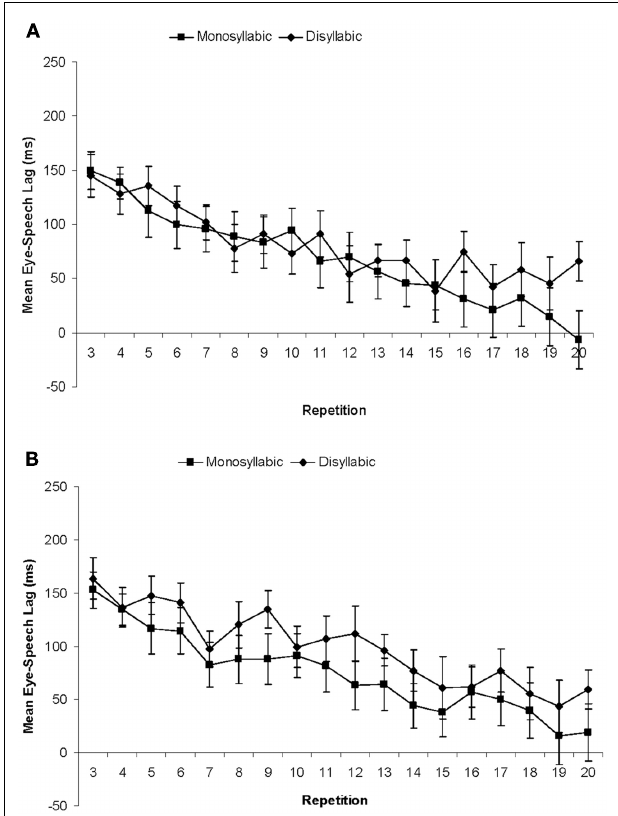
FIGURE 9 | Results of Experiment 2. Mean lags (ms) for monosyllabic and disyllabic items on repetitions 3 through 20 in the Moderate Pace Group (A) and the Fast Pace Group (B)